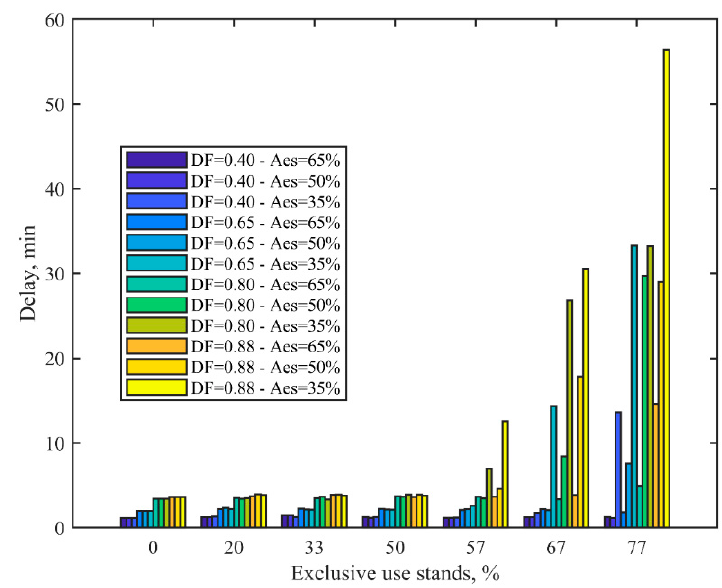
Figure 5. Delay per scenario.